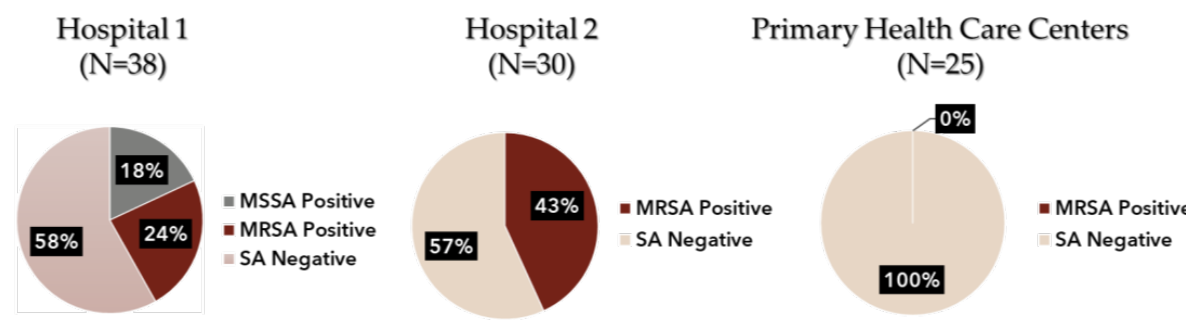
Figure 4. MRSA prevalence in the healthcare workers.